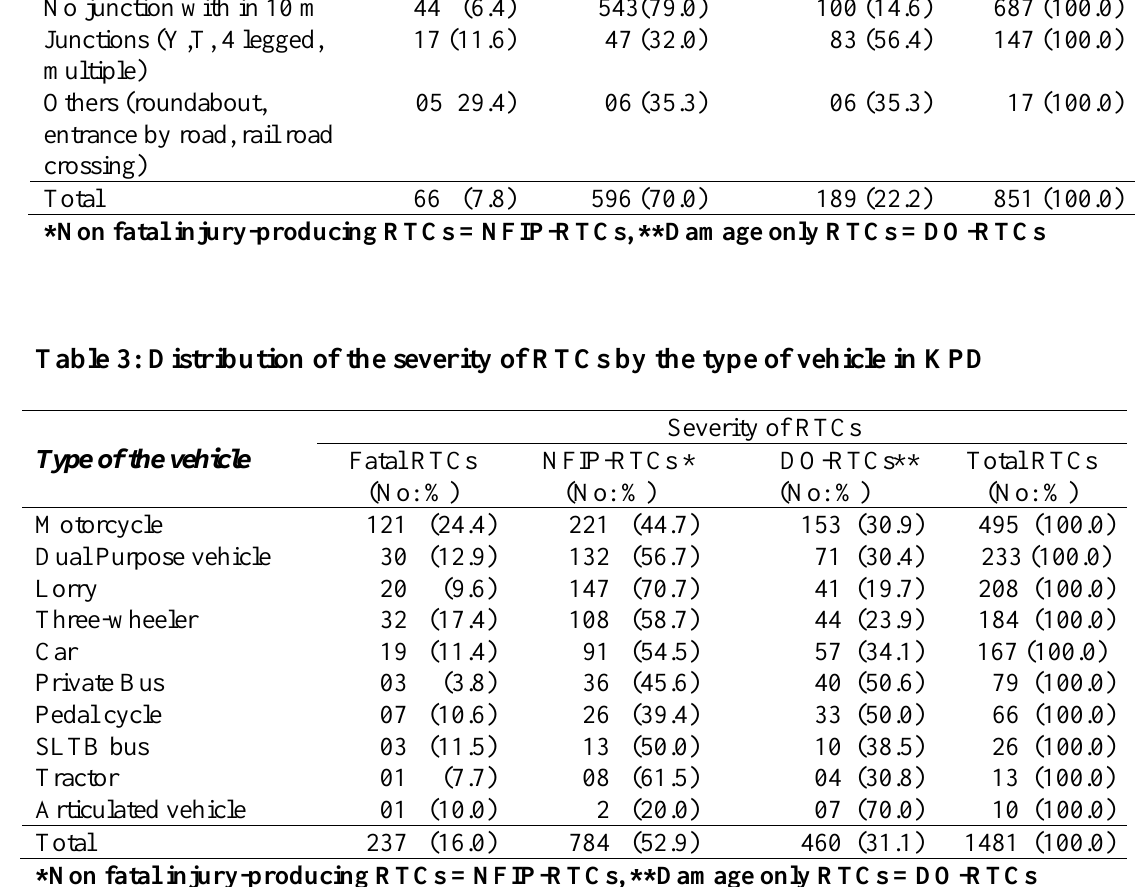
Type of junction of the road No junction with in 10 m Junctions (Y,T, 4 legged, Others (roundabout,